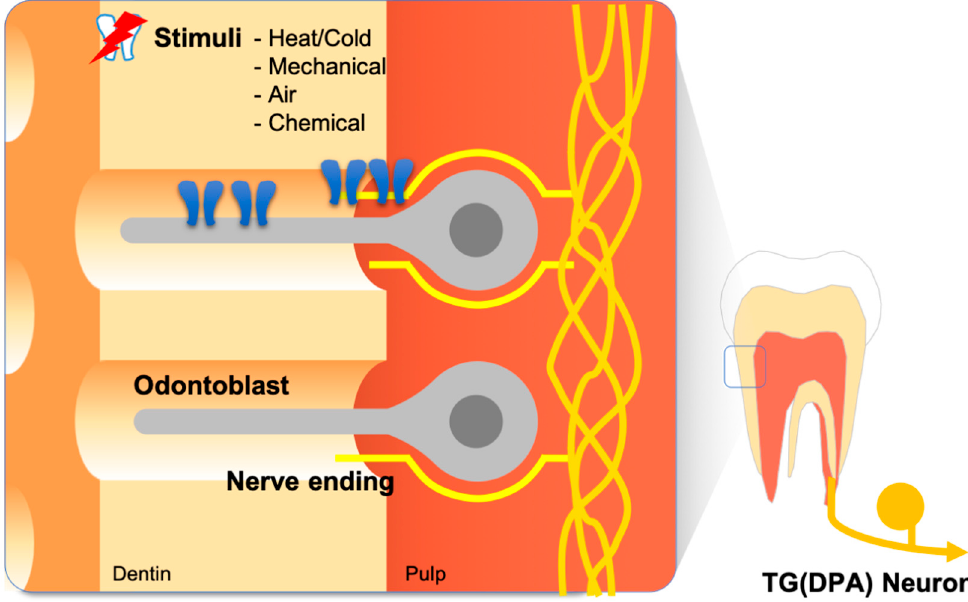
Figure 1. Anatomical features of the dental pain sensory system. Odontoblasts comprise the outermost cell layer of dental pulp tissue, which is advantageous to odontoblasts playing the role of a sensory transducer. Some nerve endings of dental primary afferents (DPAs) spread into the dentinal tubule. This structural nature establishes a distinctive sensory mechanism for the tooth.